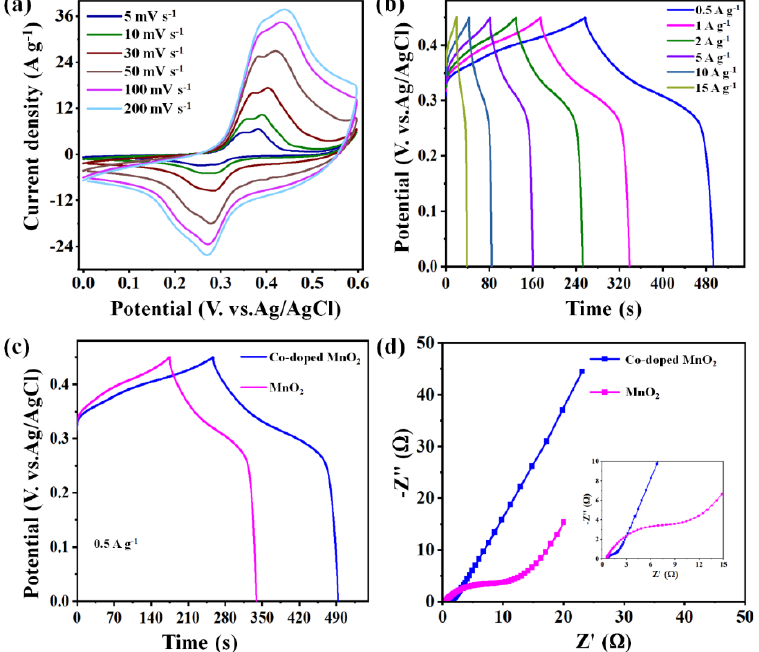
Figure 4. Electrochemical performances with the three-electrode system. ( a ) CV and ( b ) GCD curves of the cobalt-doped@MnO 2 nanosheets composite. ( c ) GCD curves at a current density of 0.5 A g −1 of binary MnO 2 nanoparticles and cobalt-doped@MnO 2 nanosheets composite electrode materials. ( d ) The Nyquist plots of binary MnO 2 and cobalt-doped@MnO 2 nanosheets composite electrode materials.